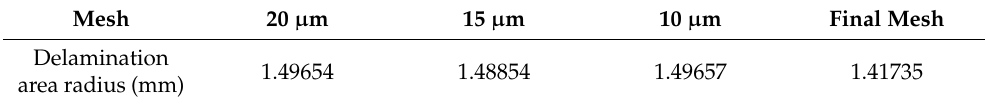
Figure 5. Impact force histories simulated using different meshes. Table 7. Predicted delamination area sizes using different meshes.